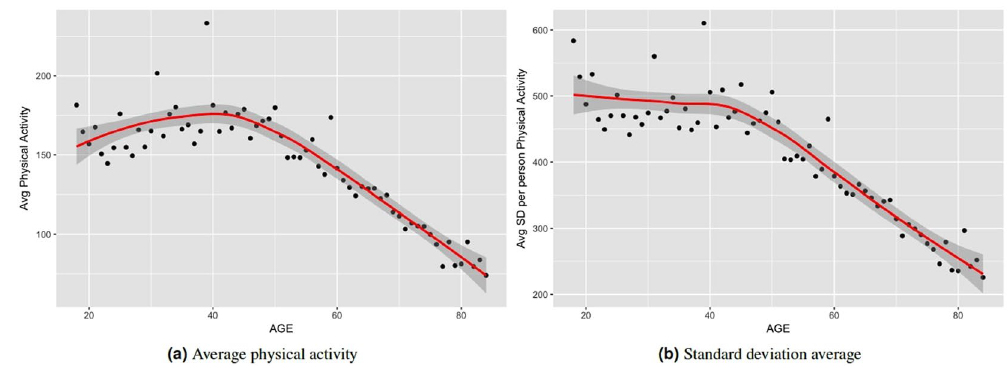
Figure 3. Variation of average physical activity with age. Values plotted for individuals grouped by year of